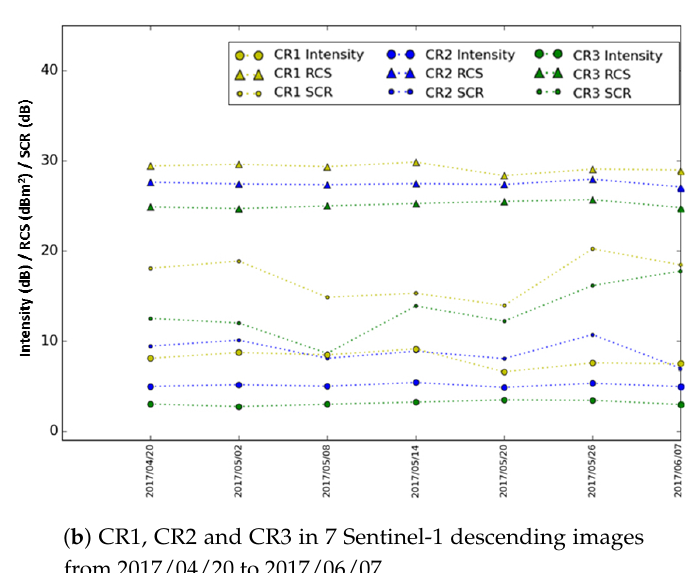
Figure 7. Intensity, RCS and SCR estimated in Sentinel-1